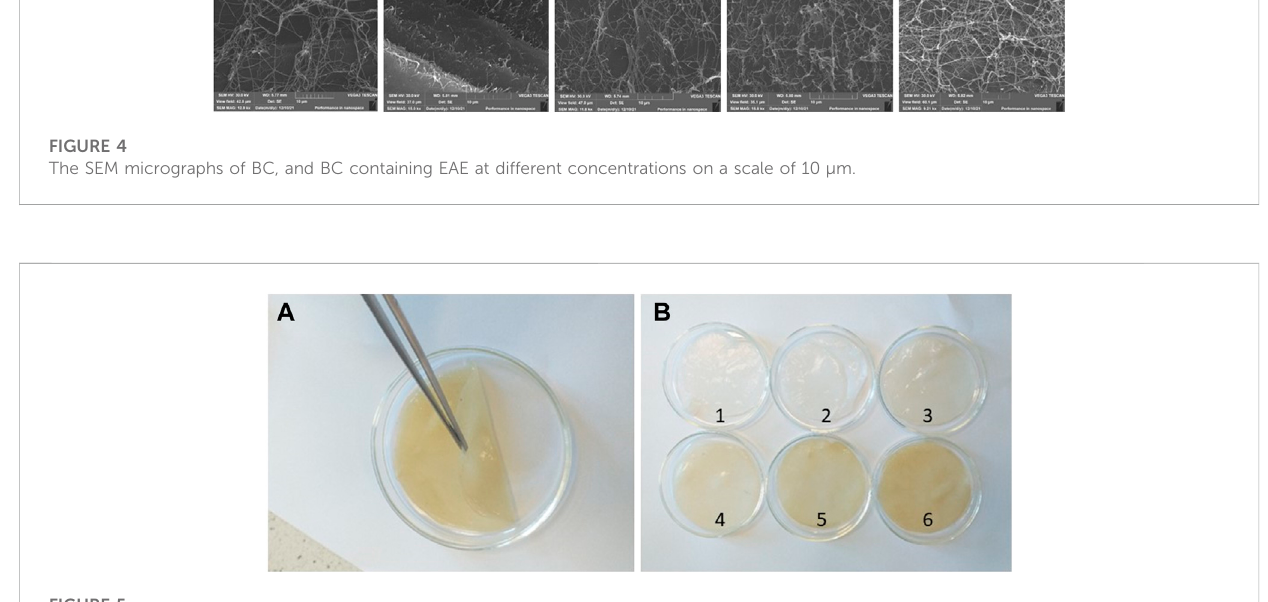
FIGURE 5 Image of a single BC before drying (A) and visual difference between the tested BC (B) : BC (1), BC-EtOH (2), BC-0.25%EAE (3), BC-0.5%EAE (4), BC- 1%EAE (5) and BC-2.5%EAE (6).